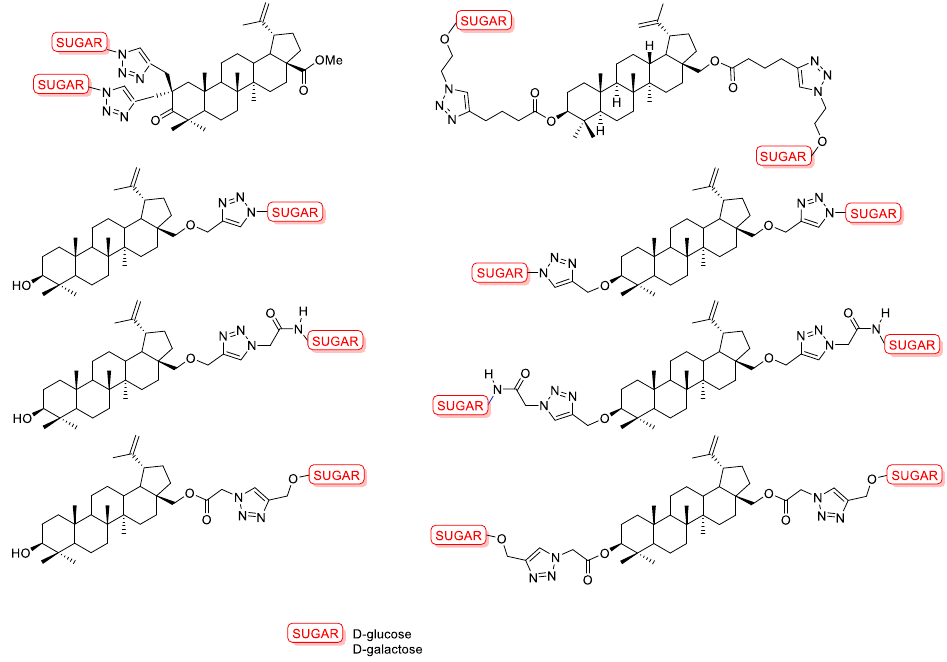
Figure 12. Pentacyclic triterpenes lupane-type glycoconjugates obtained by Click chemistry .